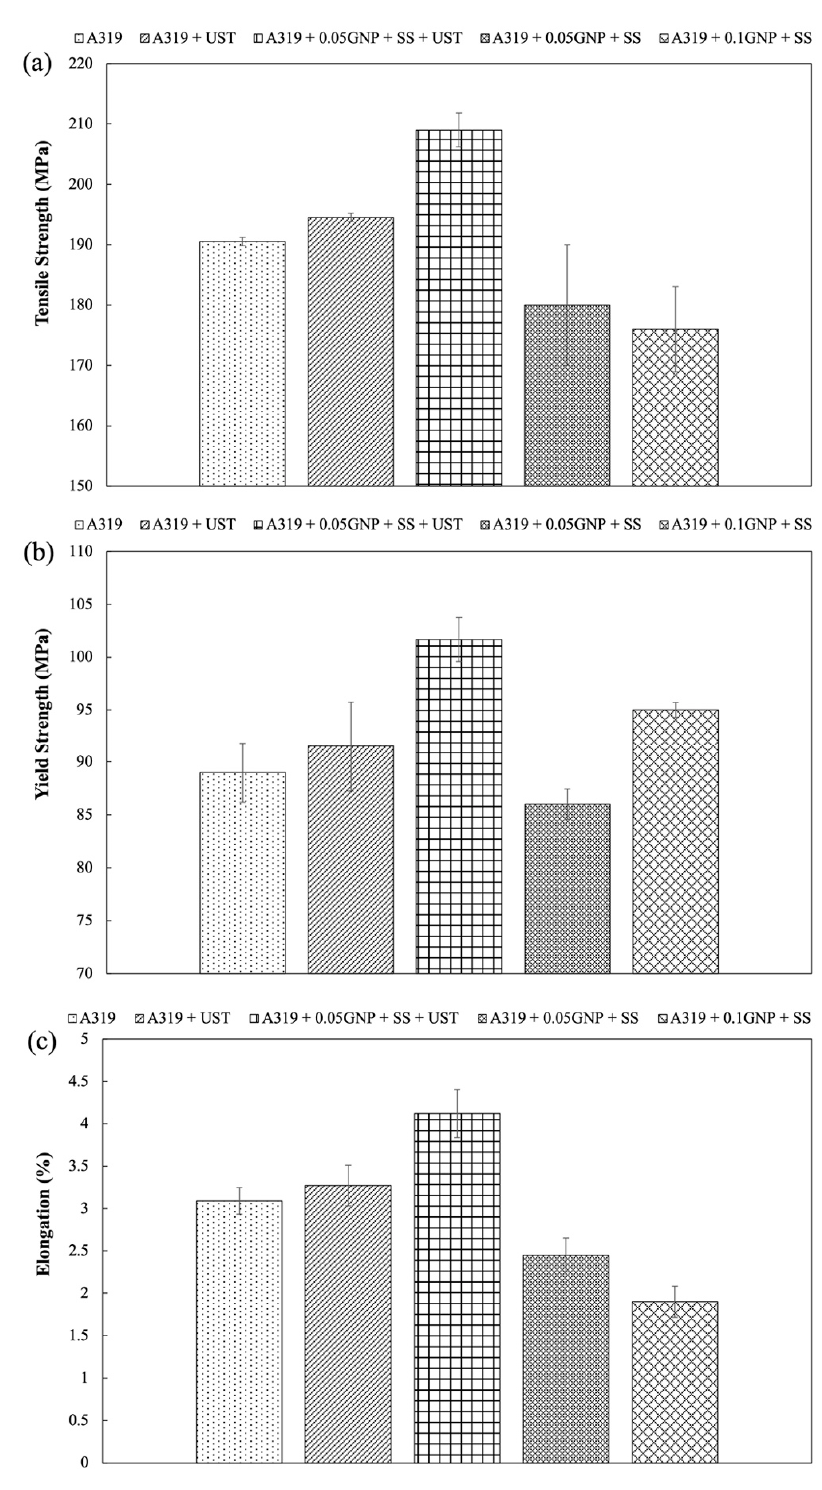
Figure 6. ( a ) Ultimate tensile strength, ( b ) yield strength and ( c ) elongation of cast samples.